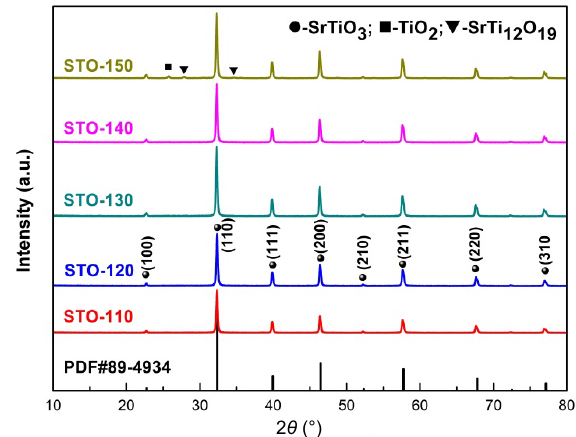
2 θ Fig. 1 XRD patterns of SrTiO 3 nanoparticles hydrothermally synthesized at various temperatures.